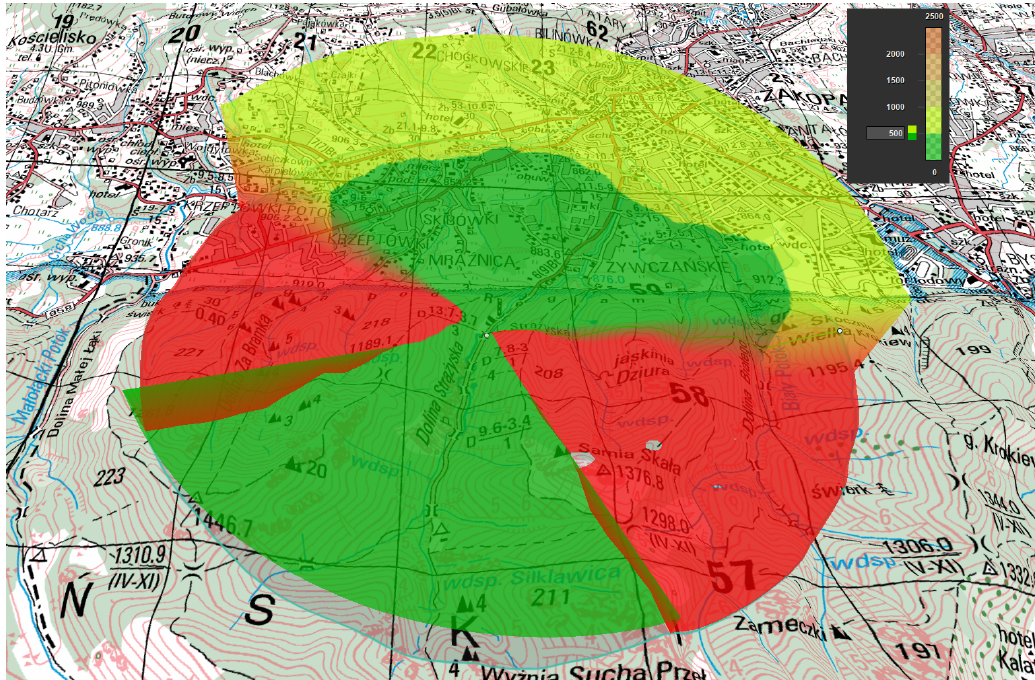
Figure 5. Line of Sight calculation in real terrain. 3D view on the map in 1: 25,000 scale generated by Luciad